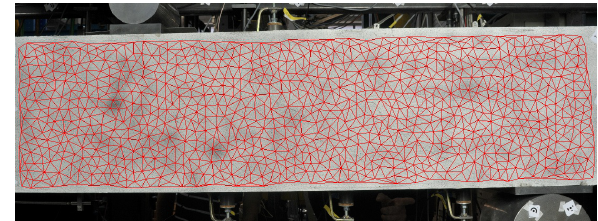
Figure 2. Triangle mesh of interest points